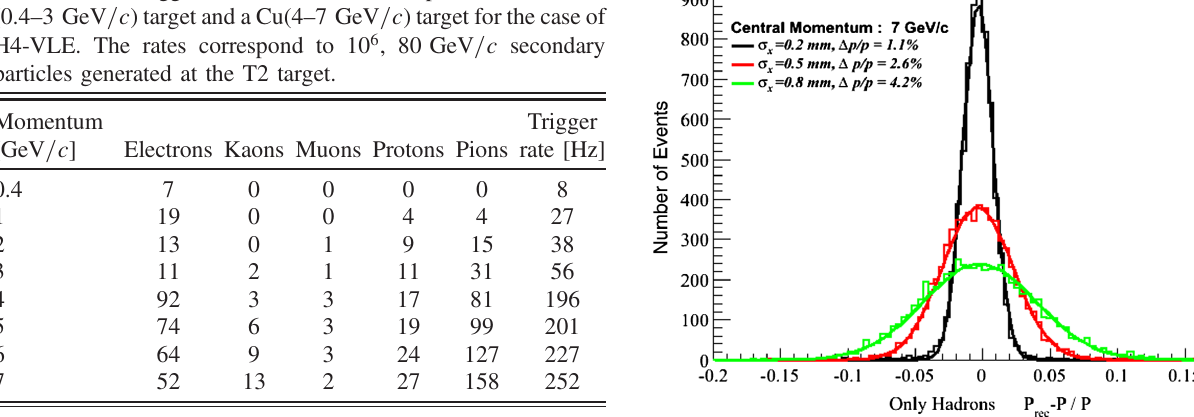
FIG. 13. Reconstructed momentum bite for a 7 GeV =c beam, taking into account the material on the beam line ( GEANT 4